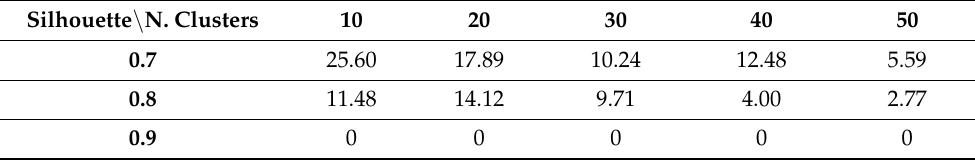
Table 17. Clustering performance in terms of silhouettes using the reduced dataset with PCA applied to normalized data.